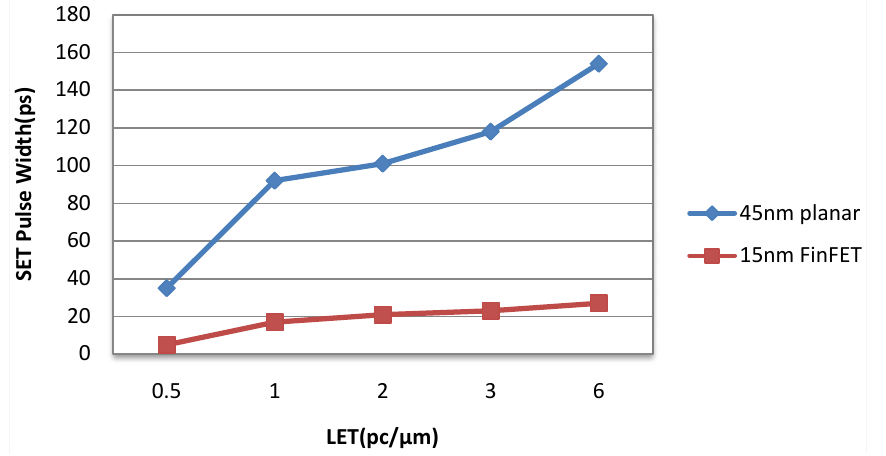
Figure 8. SET pulse width of Inverter as a function of LET for 45 nm planar and 15 nm FinFET technologies. Table 4. Calculated clock period of some benchmarks for 45 nm and 15 nm technologies. Benchmark